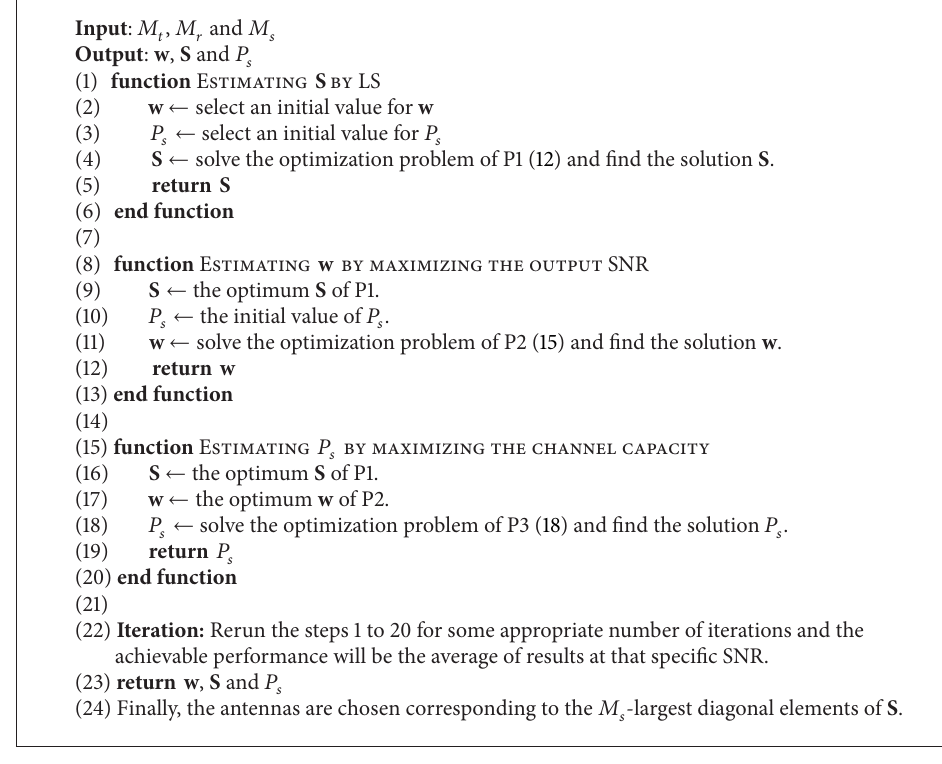
Algorithm 1: Processing procedure of the proposed low-complexity and joint transmit antenna selection and beamforming for large-scale MIMO